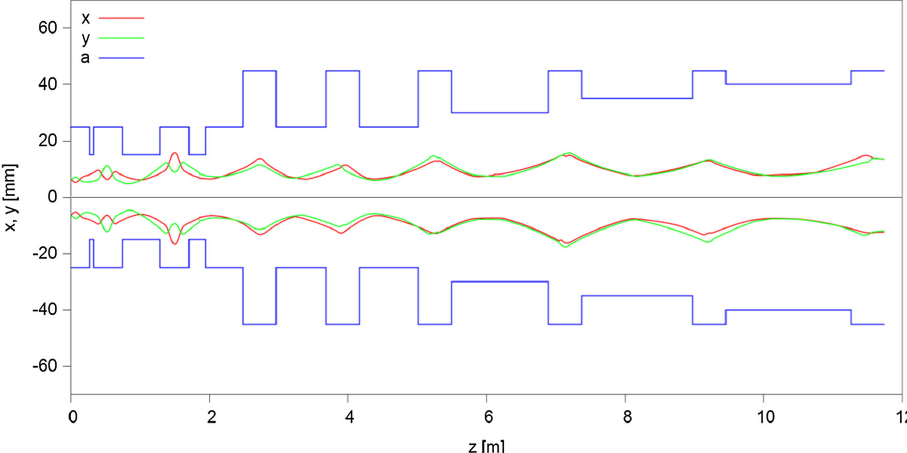
FIG. 12. Transverse 100% beam envelopes (all particles are included; red, x plane; green, y plane; blue, inner aperture of drift tubes or lenses).